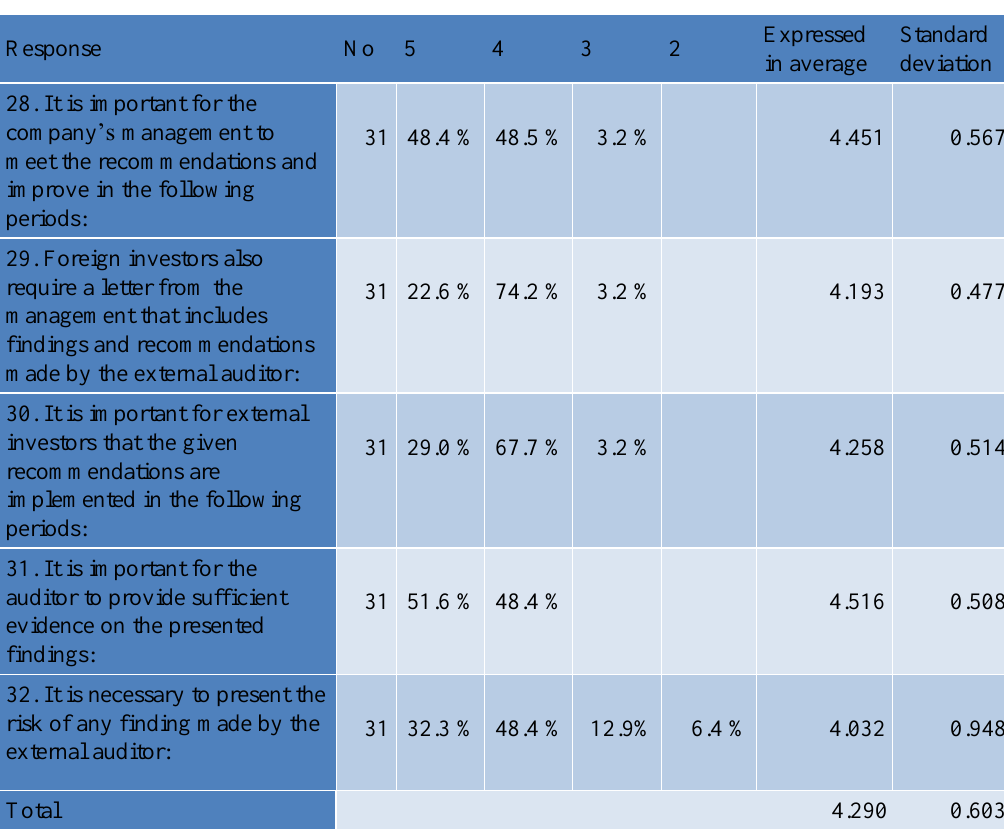
Table 7. Determinants of the relevance of the findings [Table and calculations made by